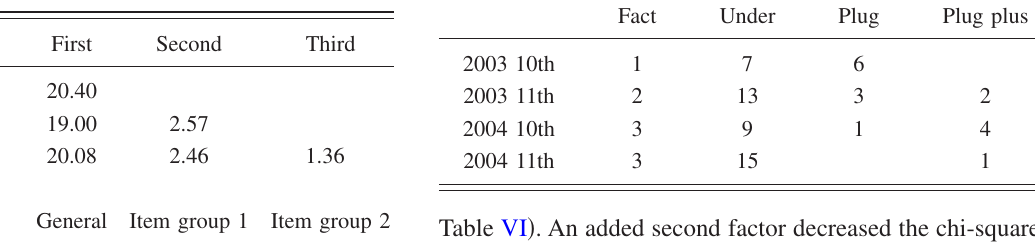
Table VI (cid:2) . An added second factor decreased the chi-squared value by 1678, which for 54 degrees of freedom (cid:1) number of items minus 1 (cid:2) is significant, and implies a substantive im- provement. Adding a third factor decreased the chi square by 402, which for 53 degrees of freedom is also significant. See Table V for the model comparisons and Table VI for the amounts of variance explained by each of the factors. When